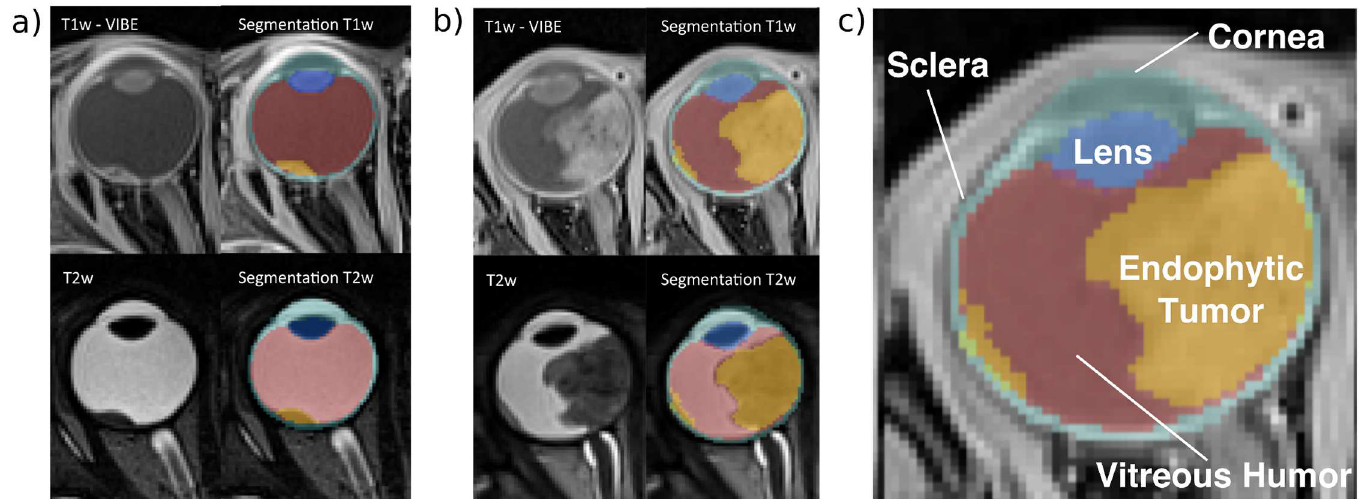
Fig 1. Patients with retinoblastoma. (a)-(b) Two examplepatients imagedwith 3D T1-Weighted (T1w) VIBE & T2-Weighted (T2w) MRI (c) The eye lens (dark blue), vitreous humor (red) and sclera / cornea(light blue) are highlighted. Endophytictumors delineated in yellow. All annotatedregions were delineatedmanually by an expert